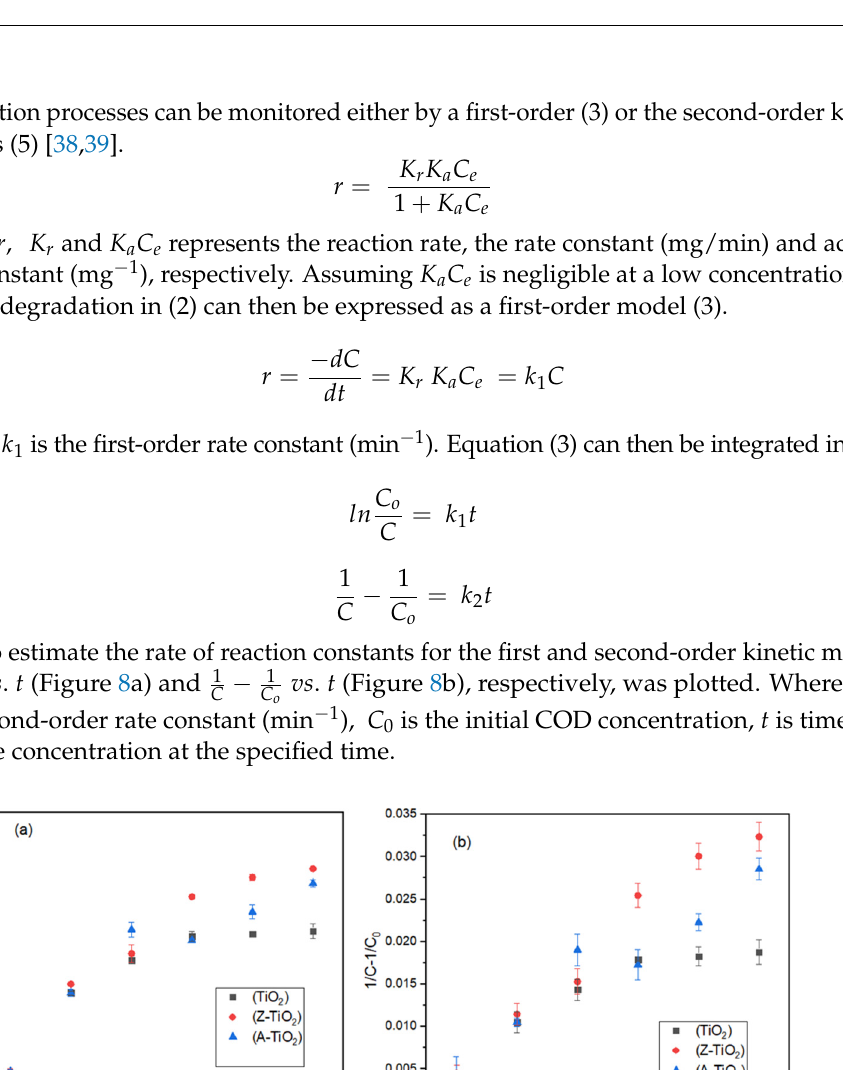
Table 2. Kinetics data for the removal of COD with a catalyst load of 4 g.